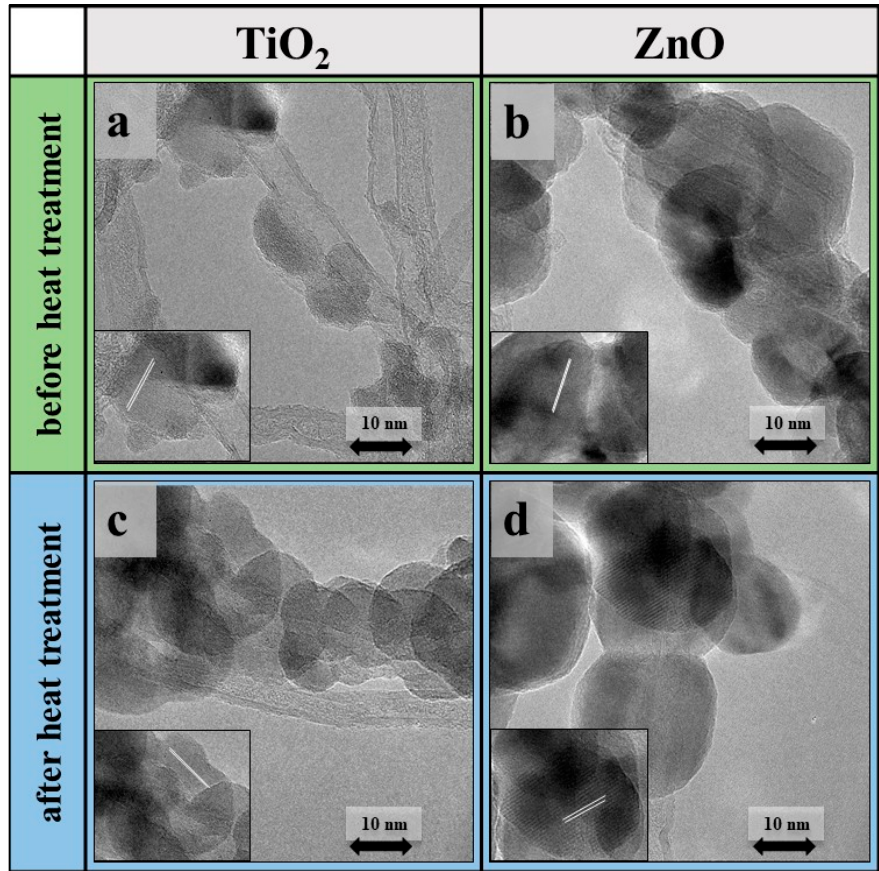
Figure 6. TEM images of TiO 2 ( a , c ) and ZnO ( b , d ) coated CNT forests before ( a , b ) and after ( c , d ) heat treatment.